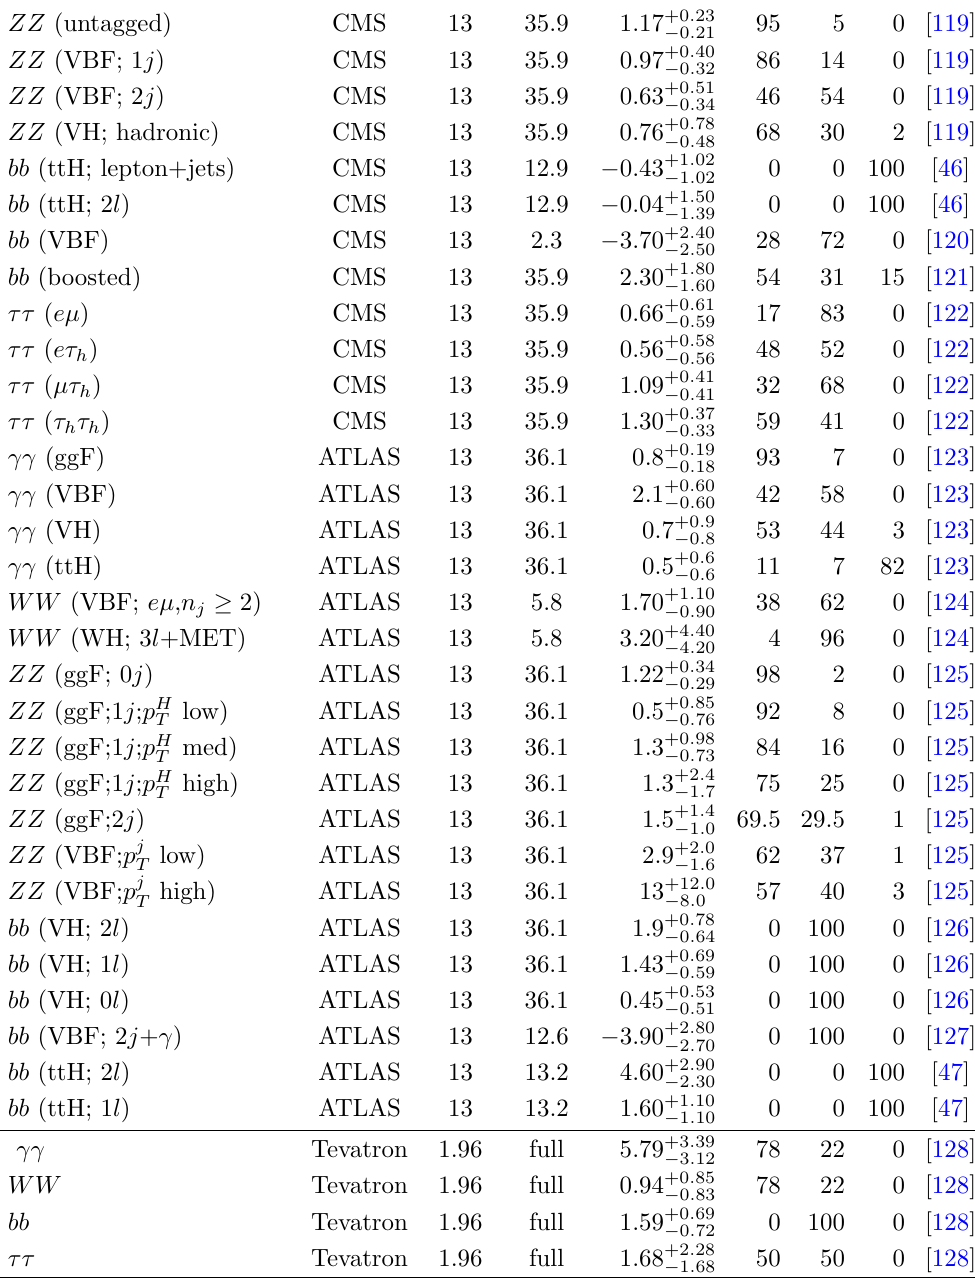
Table 1 . Signal strength (cid:22) f for current LHC and Tevatron data. The central value, sup-script and subscript for (cid:22) represents observed signal strength, 1 (cid:27) upper error bar, and 1 (cid:27) down error bar respectively. (cid:24) G , (cid:24) V , and (cid:24) t indicate for weights in the Higgs production for gluon fusion, vector boson fusion plus associated production, and associated production with tops, respectively. O(cid:14)cial values for weights are used when available, otherwise estimates are made.